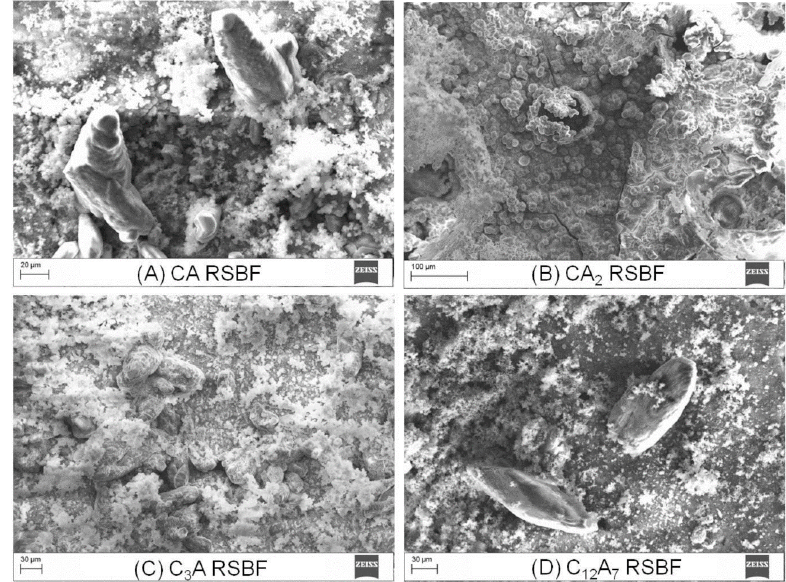
Figure 4. Electron micrographs depicting the surface of the phases (A) CA, (C) C